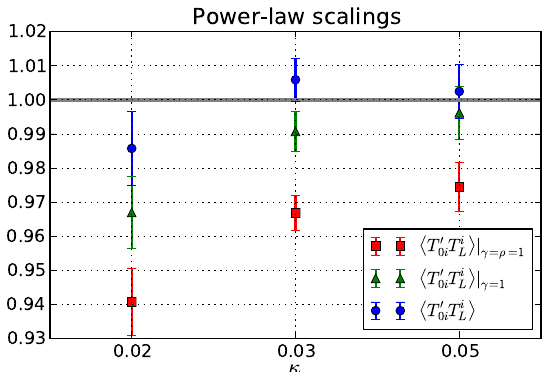
(cid:10) (cid:11) T 0 T i (circles) 0 i L (cid:10) (cid:11) T 0 T i j (cid:13) =1 (triangles) and 0 i L